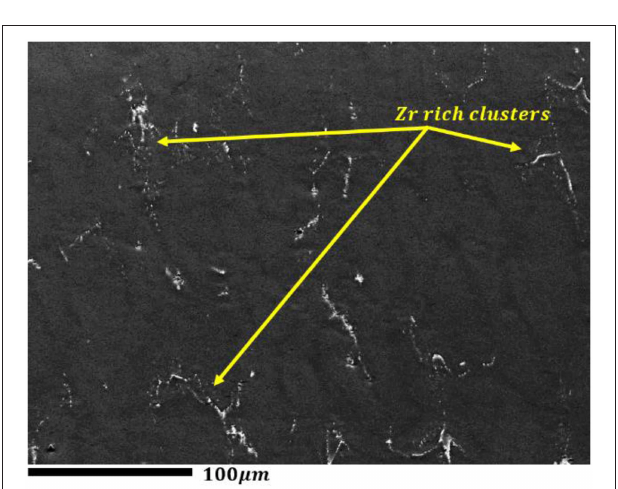
FIGURE 3 | Precipitate characterization and distribution in the ZEK110 alloy in the as-deformed state; the precipitates compositionally confer with Zr-rich phases that have been previously identified in Basu and Al-Samman